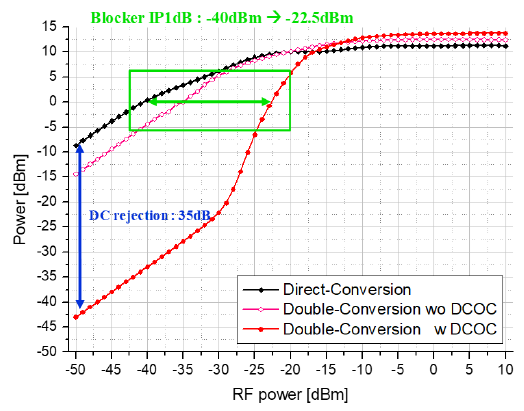
Figure 24. Simulation result of blocker P1dB and DC rejection for